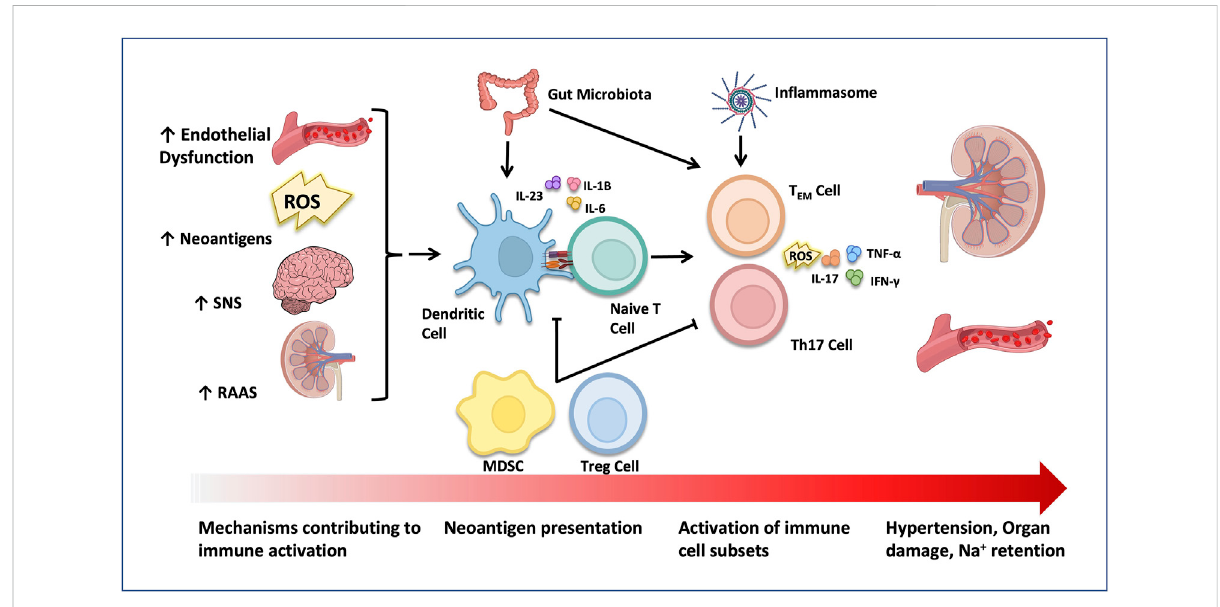
FIGURE 3 Activation of the immune system in HTN. Elevated SNS, RAAS and aldosterone activity, as well as increased ROS generation and neoantigen production have all been shown to activate immune cells in salt-sensitive HTN. Tregs and MDSCs play an anti-in fl ammatory role and suppress immune cell activation. The gut microbiome and in fl ammasome act on dendritic cells and/or T cells to contribute to HTN progression. Activated pro-in fl ammatory immune cells in fi ltrate target organs like the kidney and the vasculature and stimulate organ damage through production of ROS and pro-in fl ammatory